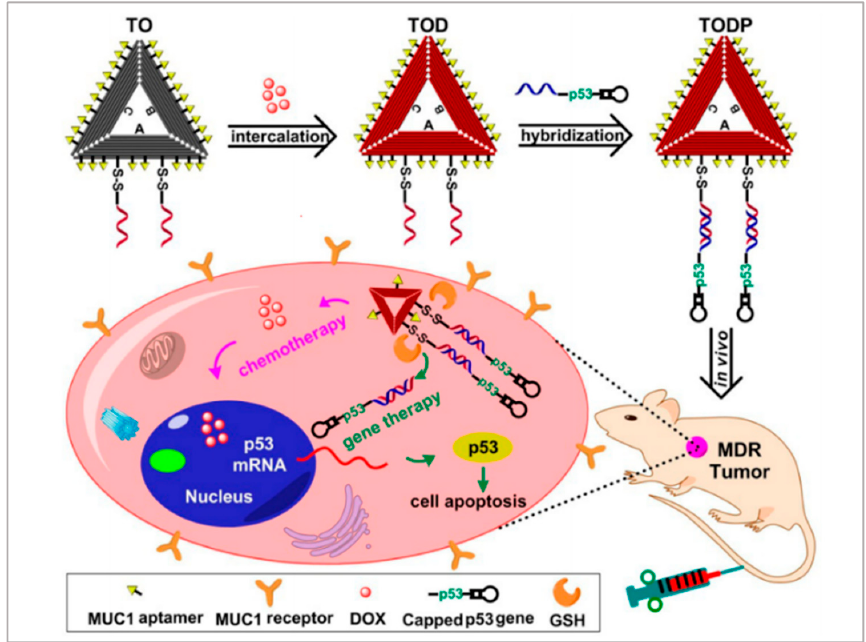
Figure 5. Schematic illustration showing the DNA nanostructure-based combination of gene therapy and chemotherapy. Reprinted with permission from [91]. Copyright © 2018 American Chemical